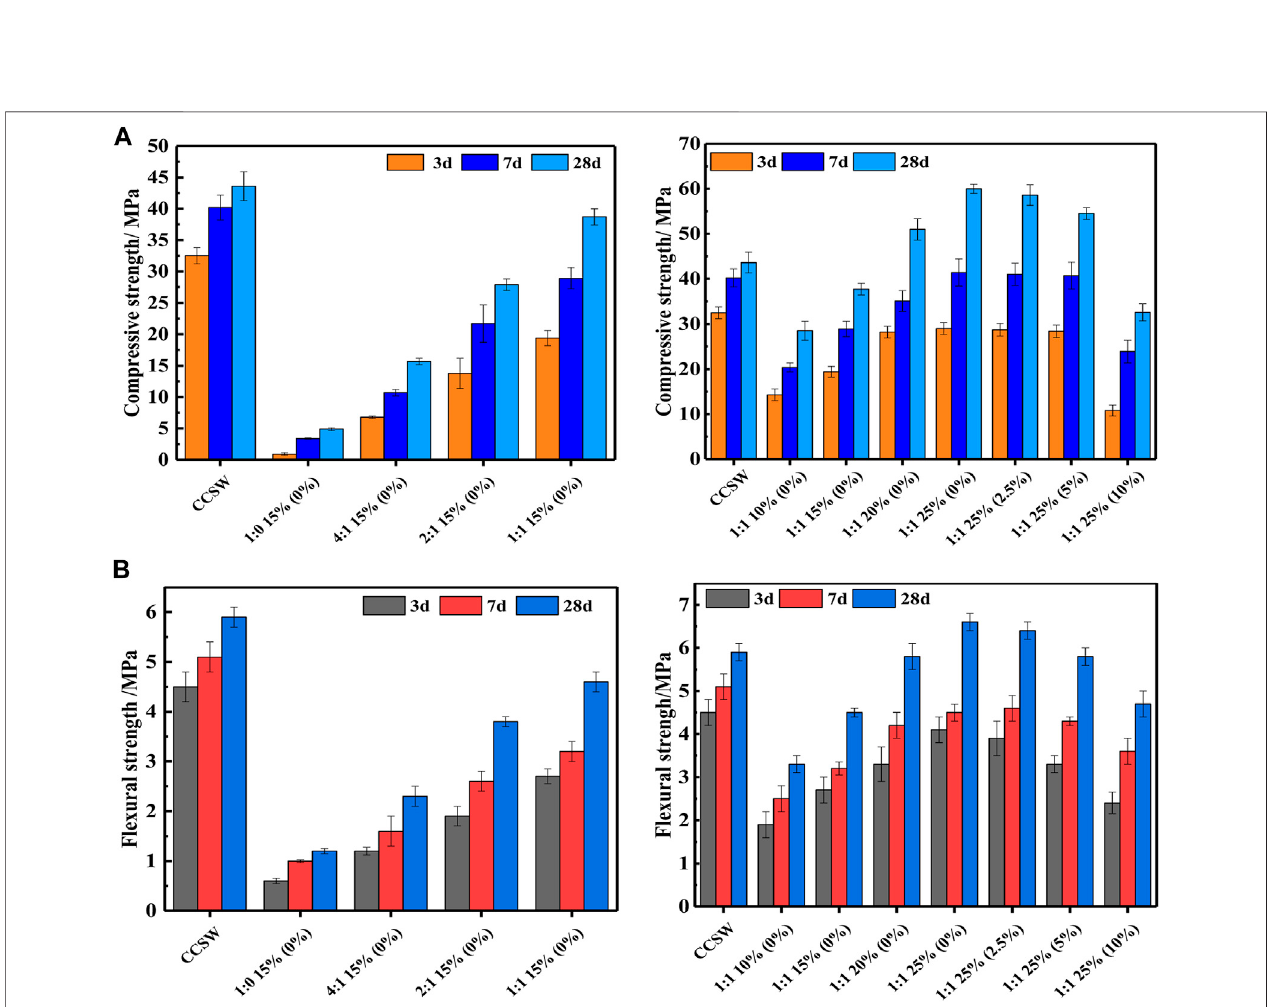
FIGURE 6 | Mechanical performances of CCSW and GCSW composites.